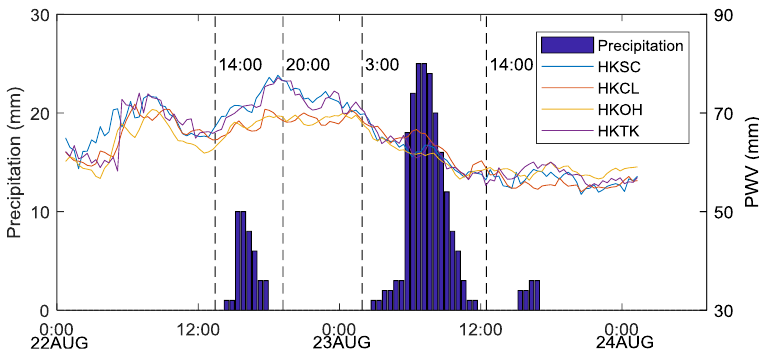
Figure 8. Relationship between the PWV (line) of four selected stations and average precipitation in HK (histogram) for the period during 22–24 August 2017.